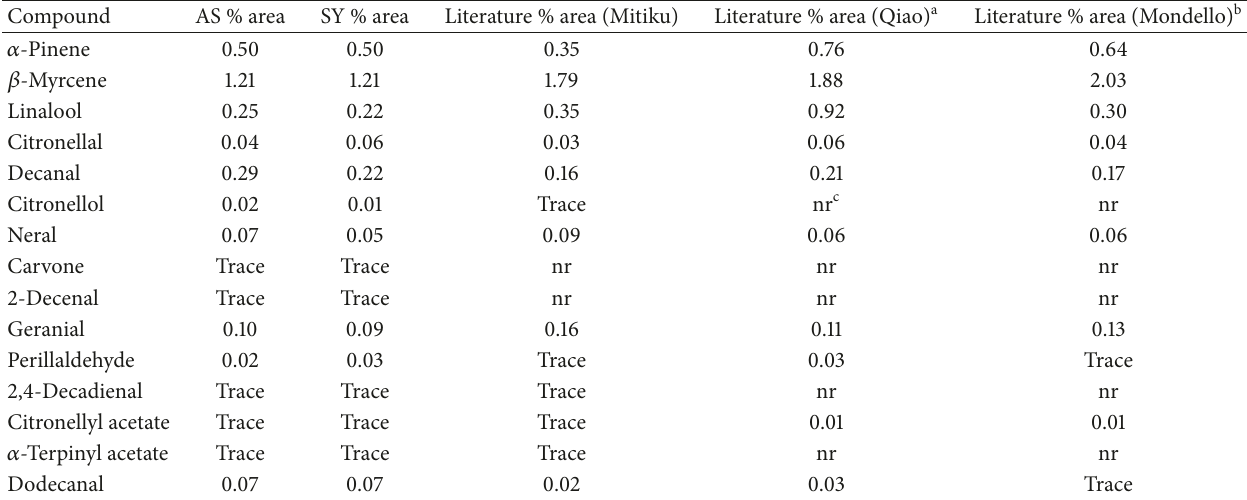
Table 12: Valencia peak area comparison to the literature